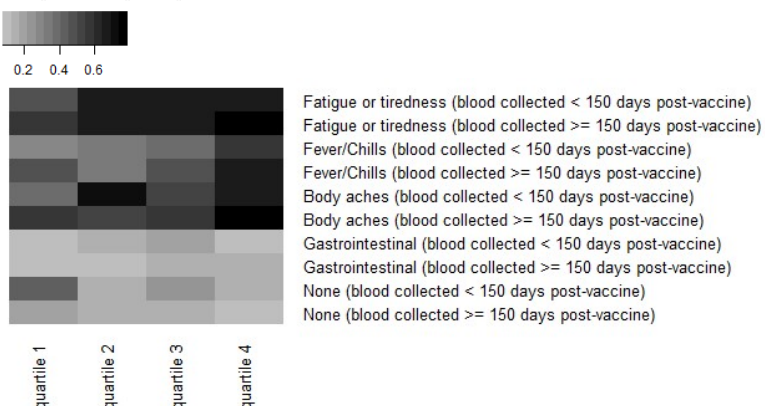
Figure 1. Heatmap demonstrating that reactogenicity post-vaccination is associated with increased Spike “S” antibody concentration. Antibody concentrations were stratified by quartiles in each timepoint and by symptoms at the time of vaccination. The quantitative IgG response to S quartiles for <150 days are: (1) 298–1440 AU/mL, (2) 1440–2606 AU/mL, (3) 2606–4198 AU/mL, and (4) 4198–16,283 AU/mL. The quartiles for ≥150 days are: (1) 166–1246 AU/mL, (2) 1246–1820 AU/mL, (3) 1820–2879 AU/mL, and (4) 2879–9278 AU/mL. Note that antibody concentrations were combined from symptoms reported before or after 150 days post-vaccination.